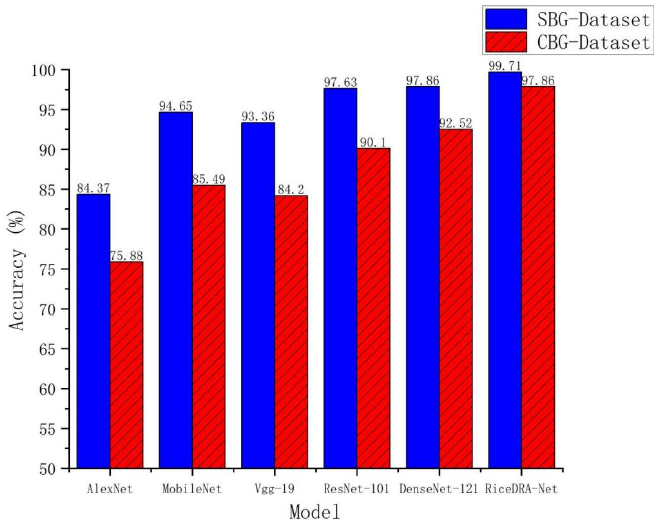
Figure 11. Comparison of model accuracy under two data sets.